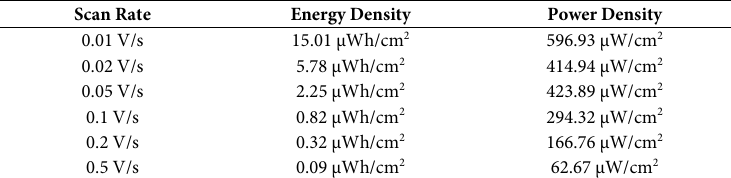
Table 2. Energy density and power density of OP-LSG coated electrode at different scan rates.